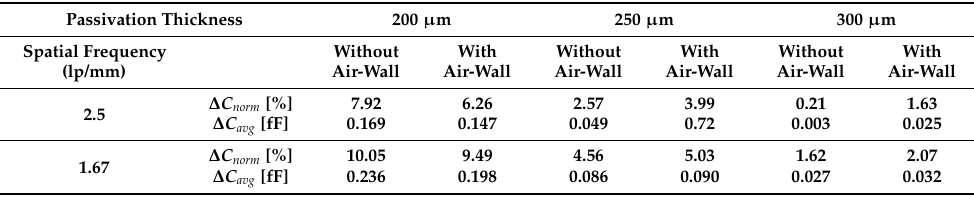
Table 4. Summary of the simulation results